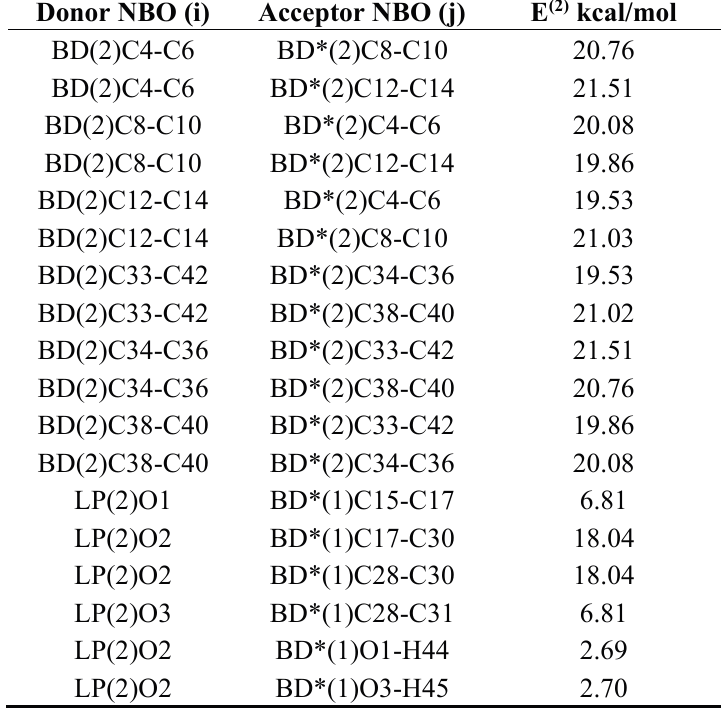
Table 5. The second order perturbation energies E (2) (kcal/mol) of the most important charge transfer interactions (donor–acceptor) of the studied compound using B3LYP